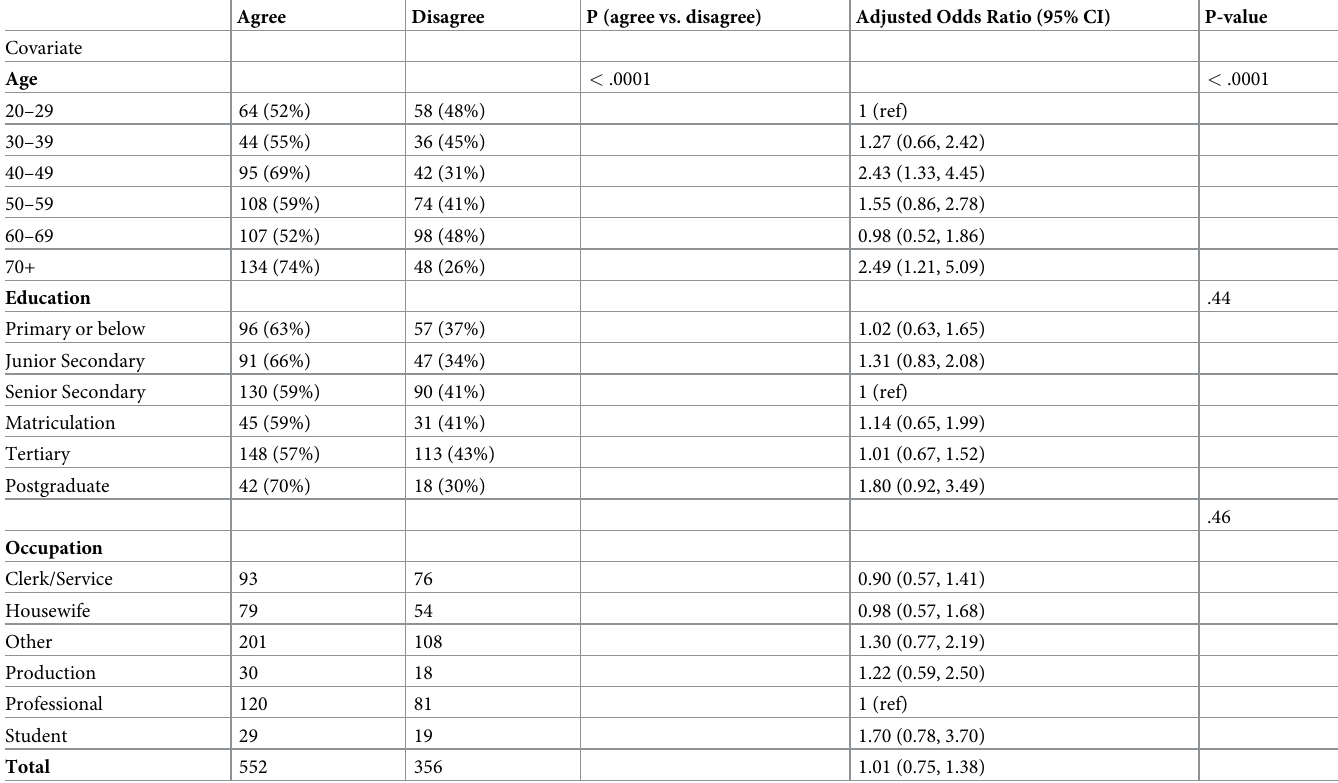
Table 1. Univariable and multiple logistic regression analysis of agree vs. disagree with government financial support for a disaster relief